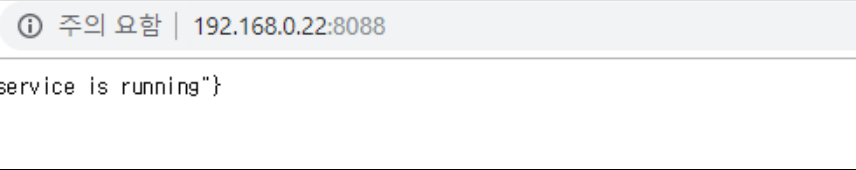
Figure 8. Result of monitoring the Kong API gateway using the root API.